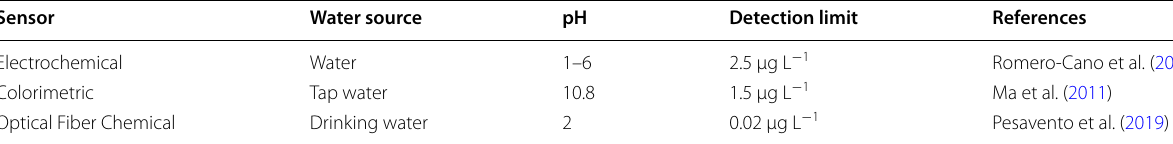
Table 4 Summary of conducted studies on Cu detection by sensors in water samples Sensor